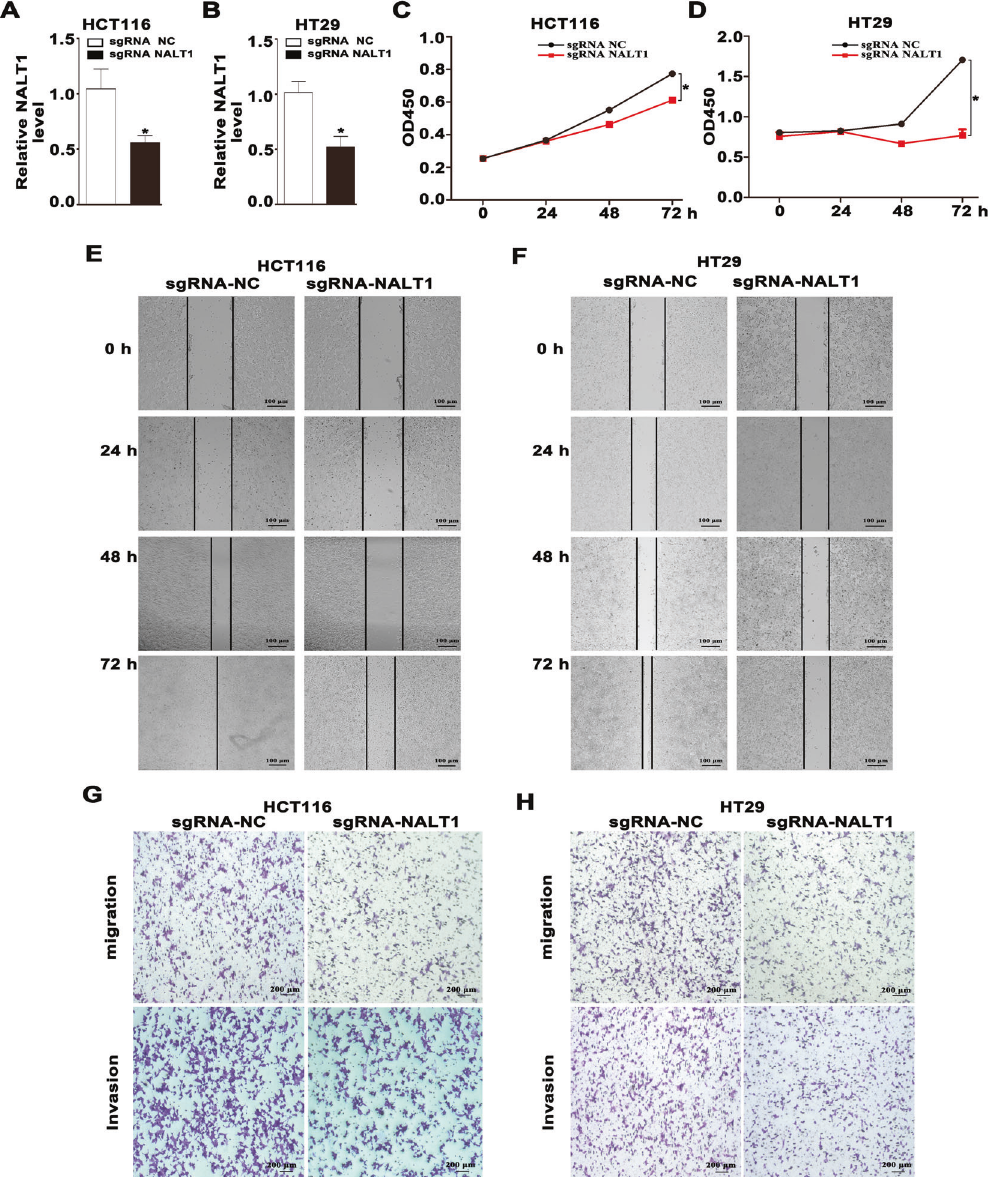
NALT1 knockdown were determined by CCK-8 assay at different time points. E – H Representative images of wound healing, migration, and invasion assays of HCT116 and HT29 cells with NALT1